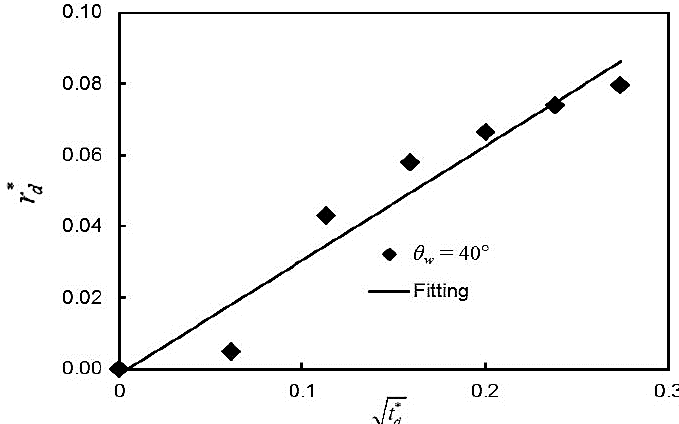
Figure 10. Variation in dimensionless spreading radius *